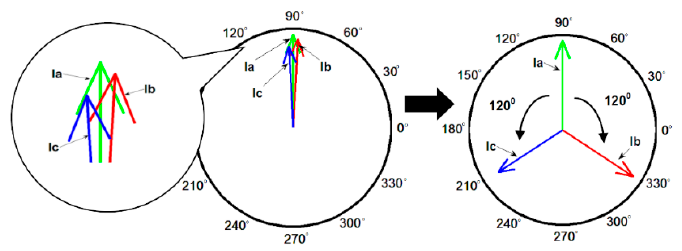
Figure 8. Illustration of the angle displacement for the sequence component analysis.